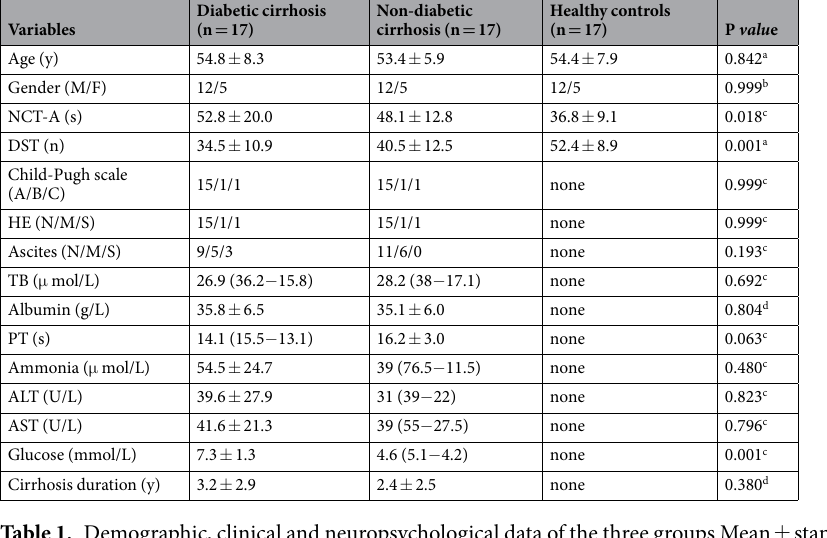
Table 1. Demographic, clinical and neuropsychological data of the three groups Mean ± standard deviation; Median and inter-quartile range [M (QU-QL)]. P values indicate significant differences across groups. a analysis of variance; b chi square test; c k-independent samples nonparametric tests d two-sample t tests. y = year; M = male; F = female; NCT-A = number connection test type A; DST = digit symbol test; s = second; n = number; HE = hepatic encephalopathy; N = none; M = mild; S = severe; TB = total bilirubin; PT = prothrombin time; ALT = alanine transaminase; AST = aspartate